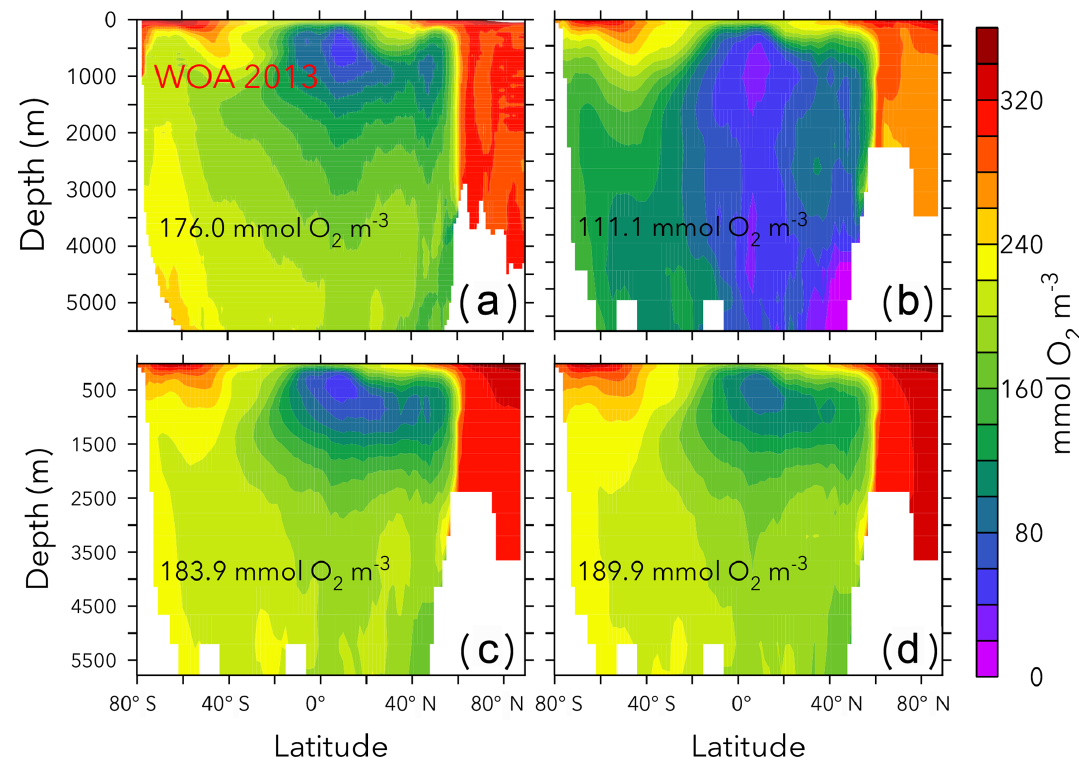
Figure 7. Same simulations as in Fig. 6 but showing the results for O 2